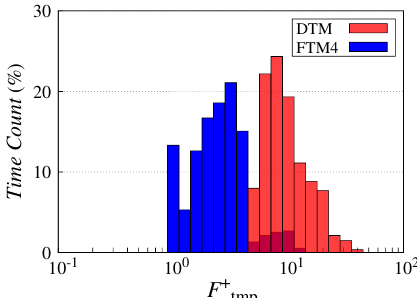
Figure 18. Temporary burst frequency ( F +